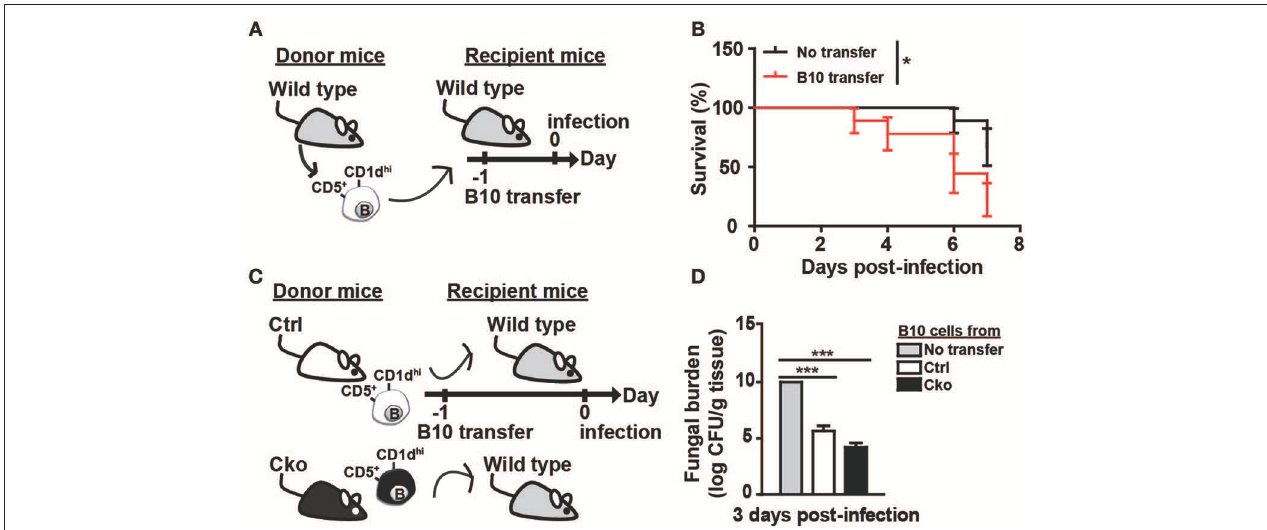
FIGURE 5 | B10 cells promoted the clearance of C. albicans . (A) Adoptive transfer of B10 cells into wildtype mice. Splenic B10 cells were purified from wildtype mice by cell sorting. Recipient mice were given either PBS or 1 × 10 6 B10 cells at 1 day before C. albicans infection. (B) The survival rates of the mice in (A) were recorded ( n > 8 mice per group). The differences in survival were analyzed by a log-rank (Mantel-Cox) test. (C) Purified splenic B10 cells from Ctrl or Cko mice were adoptively transferred into wildtype recipient mice as described in (A) . (D) The fungal burden in the kidneys was quantified in day 3 post-infection ( n = 3 mice per group). Results are from at least two independent experiments and were analyzed using an unpaired Student’s t -test. Data are the mean ± SEM. * p < 0.05 and *** p <